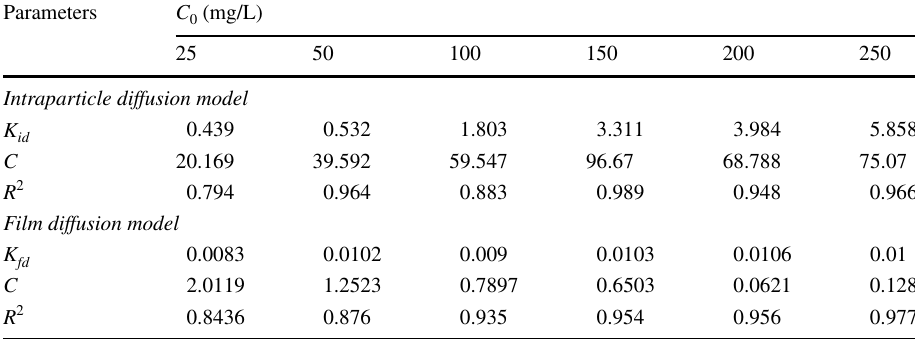
Table 5 Intraparticle diffusion and film diffusion parameters for adsorption of MB onto BNH-CM at different initial